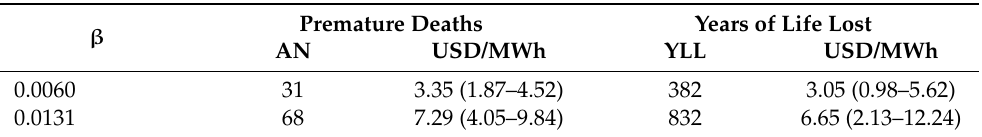
Table 3. Mortality burden of coal-fired power generation in the NSW Greater Metropolitan Region emissions (2013). Premature Deaths Years of Life Lost β AN USD/MWh YLL USD/MWh